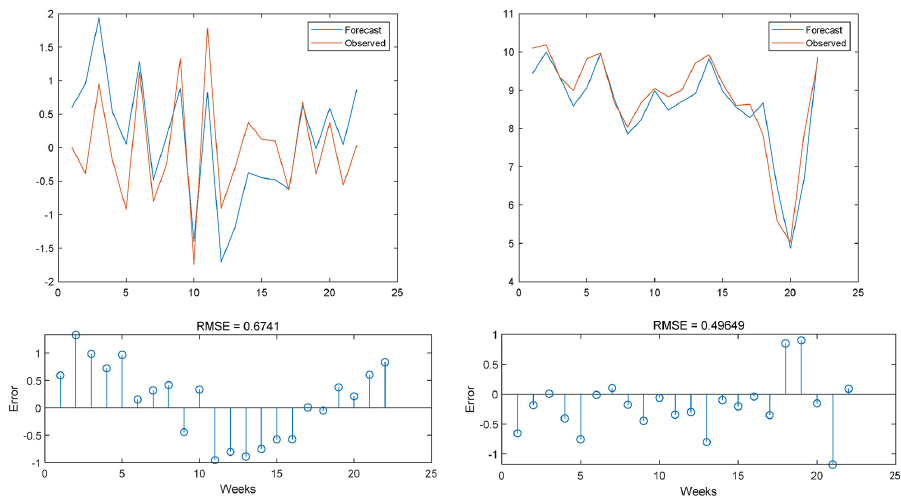
Figure 9. Prediction results and error images of the ANN-WT-LSTM model for high-frequency and low-frequency parts of the Do verification set.